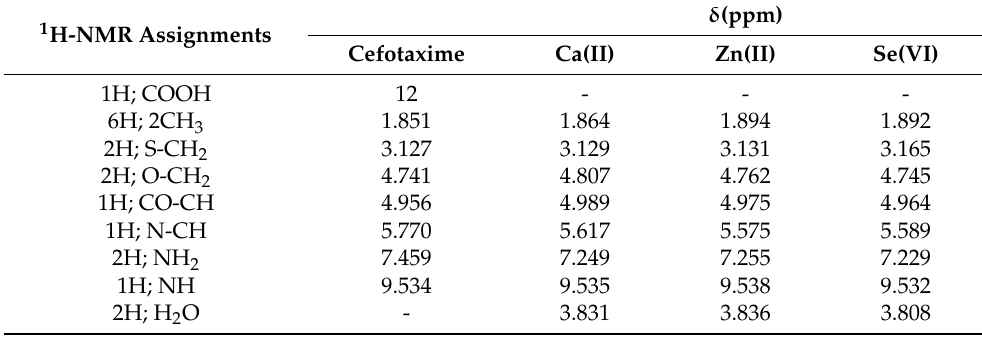
Table 4. 1 H-NMR assignments for free-ligand cefotaxime and its metal